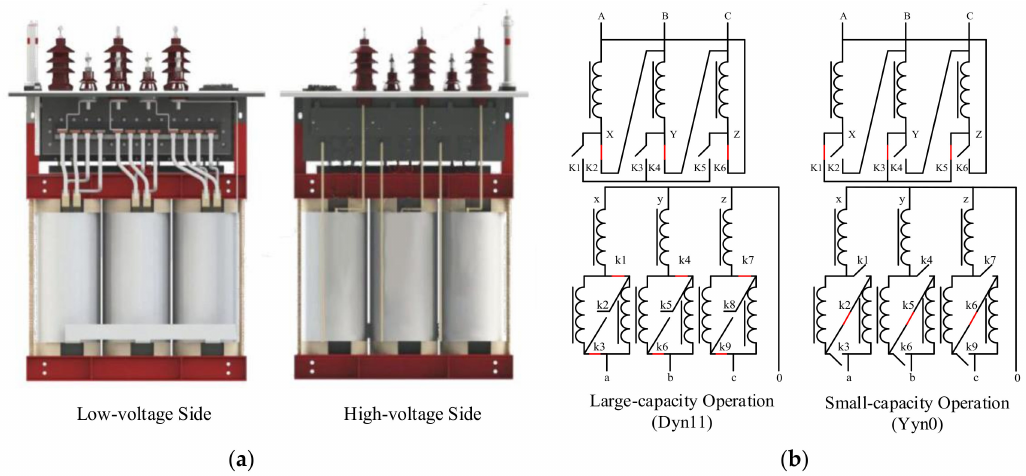
Figure 1. On-load capacity regulating distribution transformer. (a) actual pictures; (b) circuit